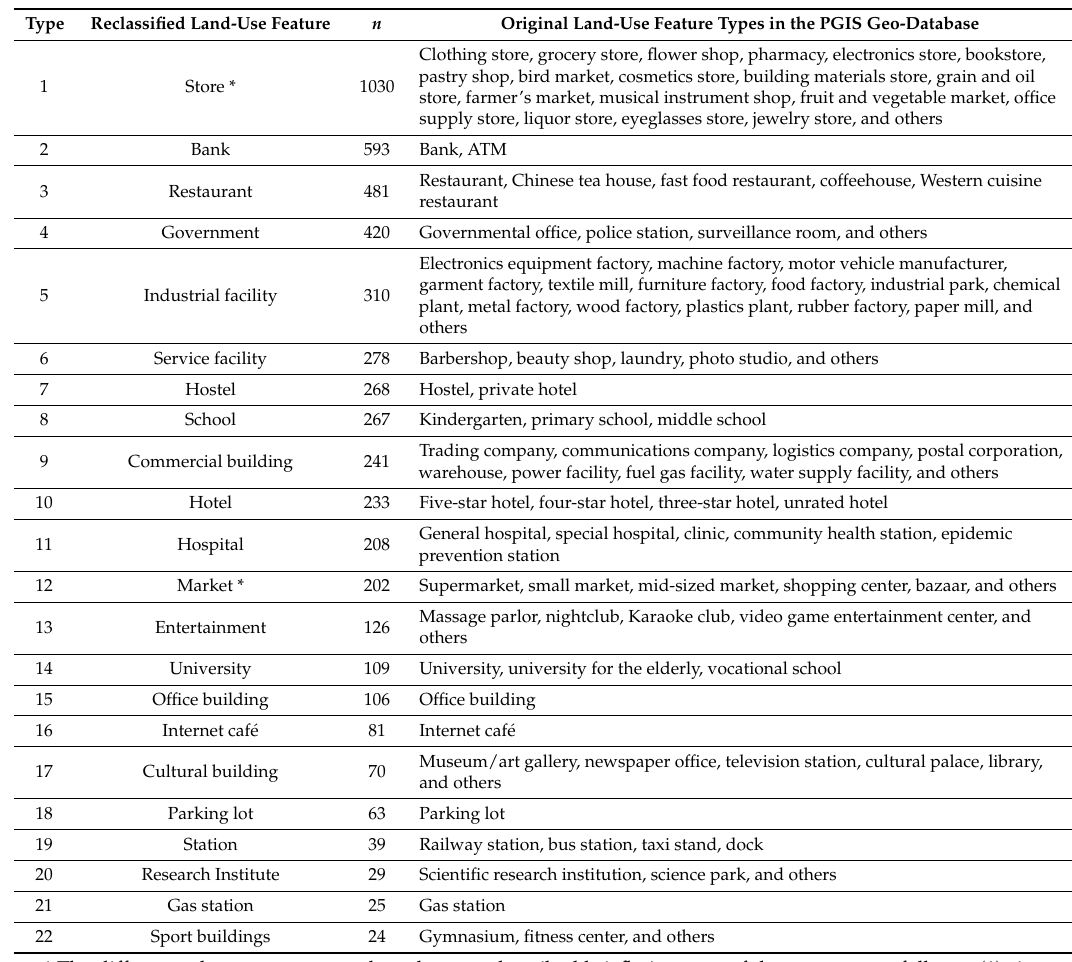
Table 1. Reclassified land-use feature types, numbers of cases, and original